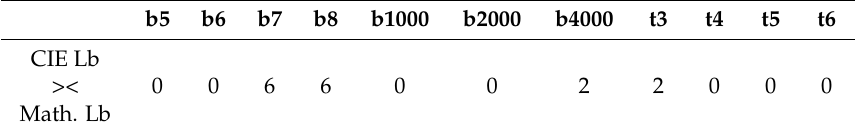
Table 6. Significant difference scores (%) between the two background luminance definitions (field study).